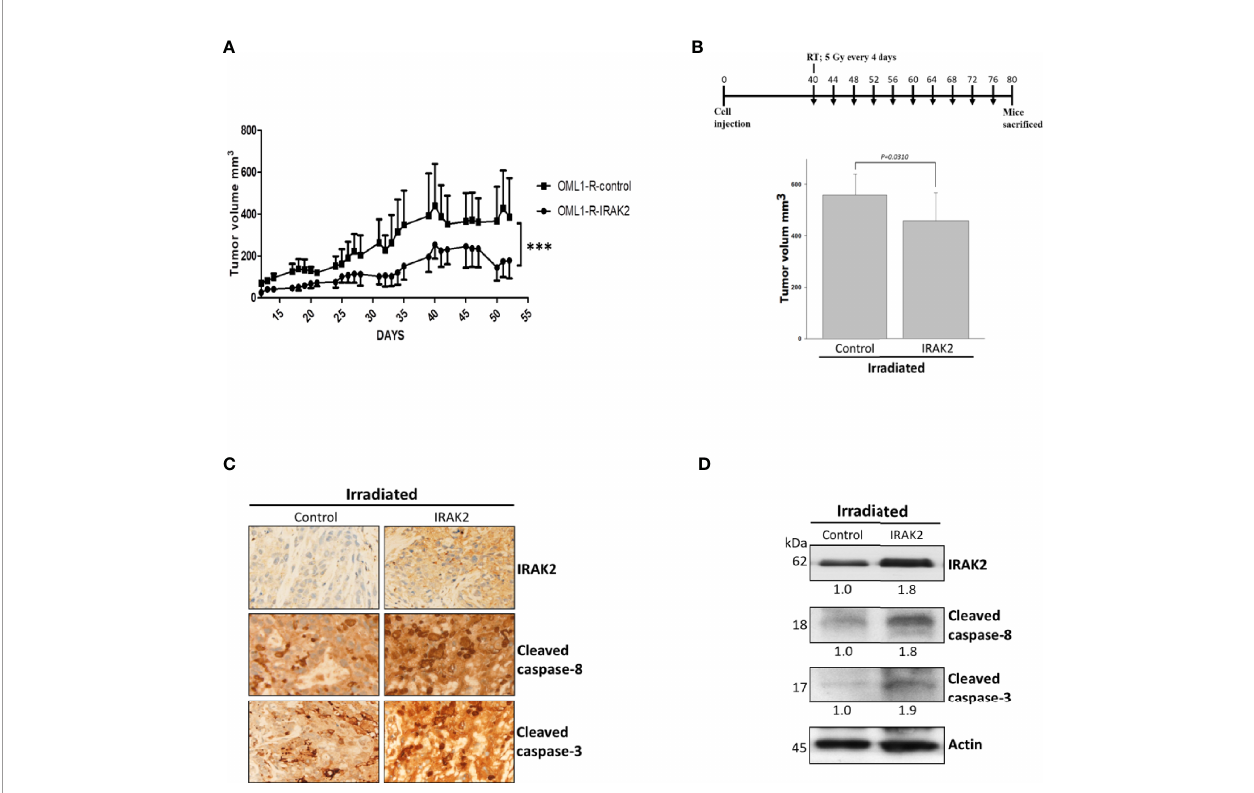
FIGURE 4 | IRAK2 overexpression decreased OML1-R-generated in vivo tumor growth and enhanced radiosensitivity in the mice xenograft model. (A) In the mice xenograft model, IRAK2-overexpressed OML1-R-generated tumors had a relatively lower tumor growth rate than that of control OML1-R-generated tumors (P < 0.001). (B) Schema of cell injection and radiation treatments (upper panel). Since the 40th day after cancer cell injection, control and IRAK2-overexpressed mice were treated with RT per 4 days (i.e., a fraction size of 5 Gy by ten fractions to an accumulative dose of 50 Gy). The IRAK2-overexpressed mice had a smaller tumor volume than that of control mice at the time of radiotherapy (P = 0.0310; lower panel). (C) The expression of IRAK2, cleaved caspase-8, and cleaved caspase-3 in tumor tissues from control and IRAK2-overexpressed mice after radiotherapy were detected by immunohistochemical staining. (D) Immunoblotting analysis of the indicated proteins in lung tissues from control and IRAK2-overexpressed mice after irradiation. Densitometry-derived values (bottom) were normalized with the control set as 1. b -actin served as the loading control for normalization. Data were presented as mean ± SD. ‘ *** ’ represented P < 0.001. All experiments were performed in